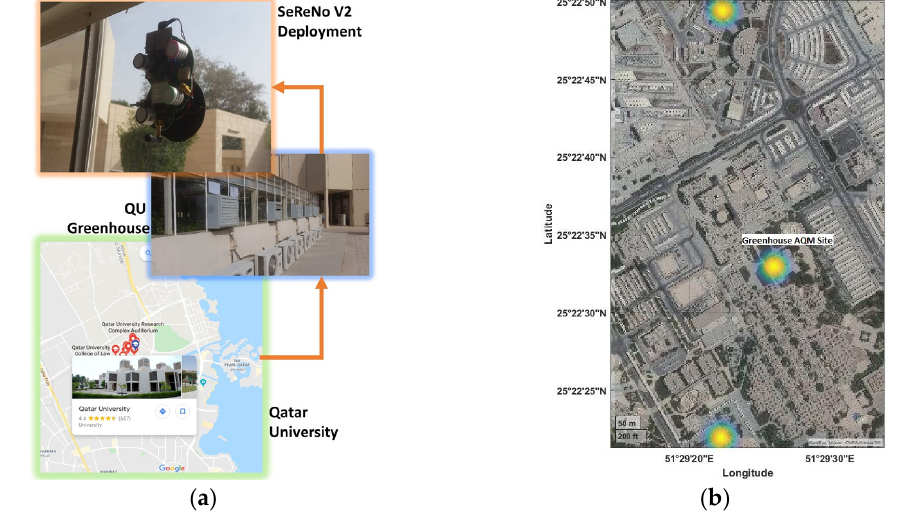
Figure 4. The SeReNo V2 Deployment in QU to utilize the GAM-based OBRM: ( a ) The Greenhouse Site Details and ( b ) The Bi-cluster data-fusion at the central site.